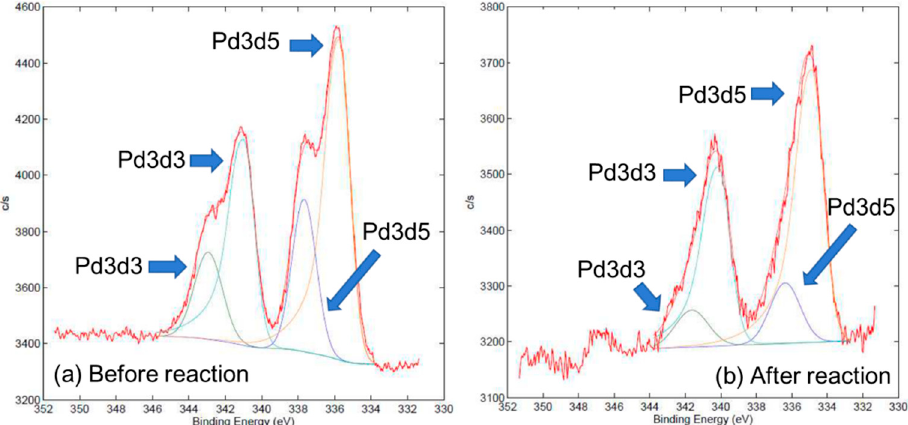
Figure 2. XPS spectra of 5% Pd/TiO 2 (Cat. D , anatase-type) before ( a ) and after ( b ) the Suzuki–Miyaura coupling reaction.